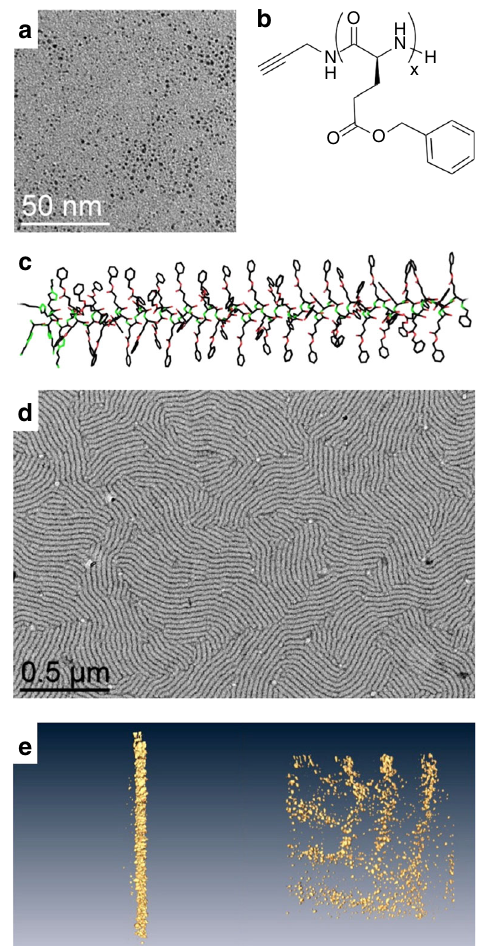
Fig. 1 Building blocks and self-assembly. a TEM image of pristine ultra- small platinum nanoparticles of 1.2 ± 0.3 nm. b Chemical structure of PBLG — in the present study, x = 28 ( PBLG1 ), 69 ( PBLG2 ), 120 ( PBLG3 ), 217 ( PBLG4 ), 481 ( PBLG5 ). c Geometrical model of the α -helix conformation of PBLG (example for x = 60). Lamellar structuration of an assembly of platinum nanoparticles with PBLG4 at 0.5 eq.: d Low-magni fi cation TEM image; e , Tomographv 3D reconstruction at two viewing directions: each yellow dot corresponds to an individual